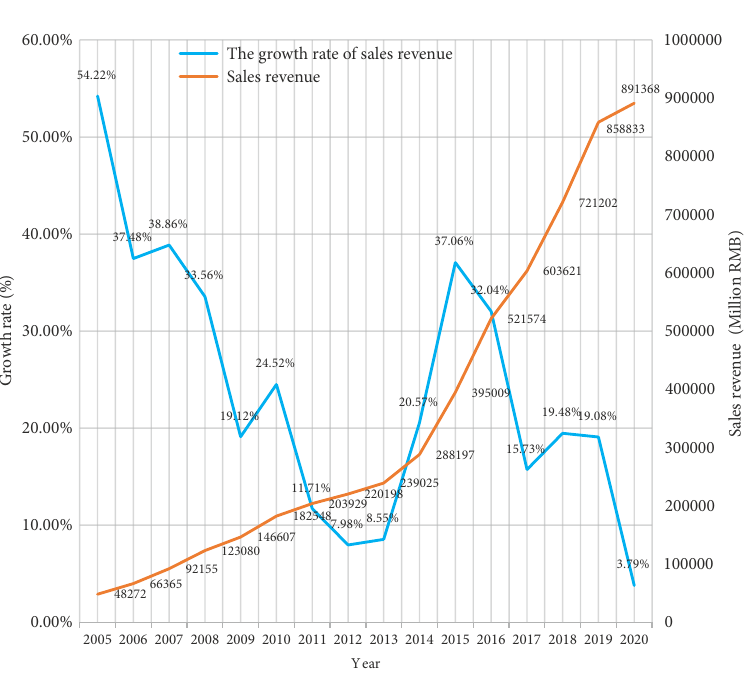
Figure 10. The growth rate of revenue in